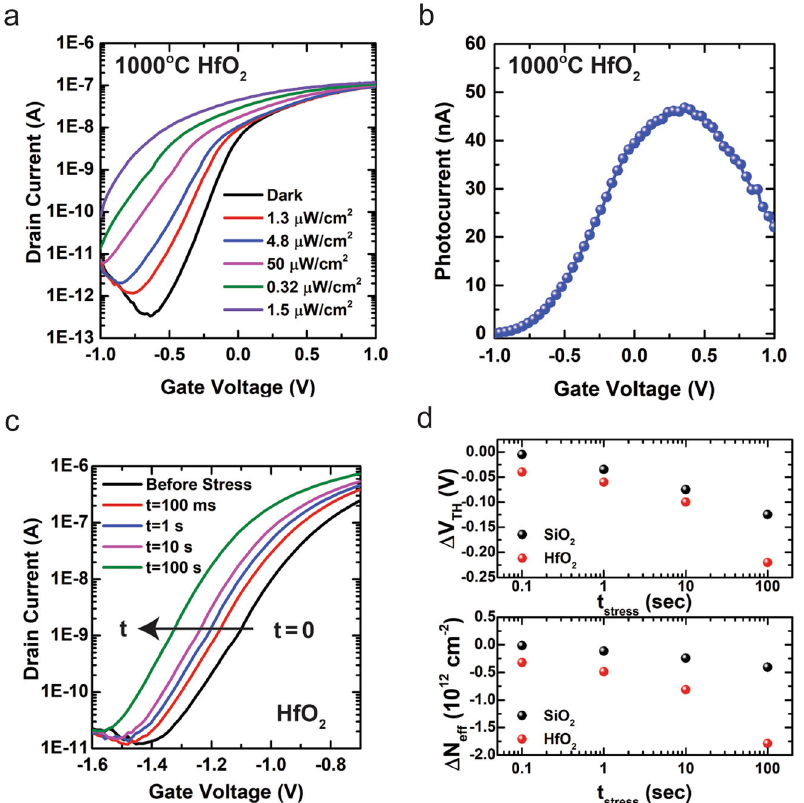
Fig. 3 Effects of thermal annealing and potential of hole trapping. a Photoresponse of the 1000°C RTA annealed HfO 2 phototransistor. b Photocurrent generation of the 1000 °C RTA annealed HfO 2 phototransistors at 1.5 mWcm − 2 . c Stress and sense I D – V G measurement of HfO 2 device under dark condition with V G = − 2 V stress bias at various stress times. d Top: threshold voltage shift from negative bias stress (NBS). Bottom: effective defect generation from